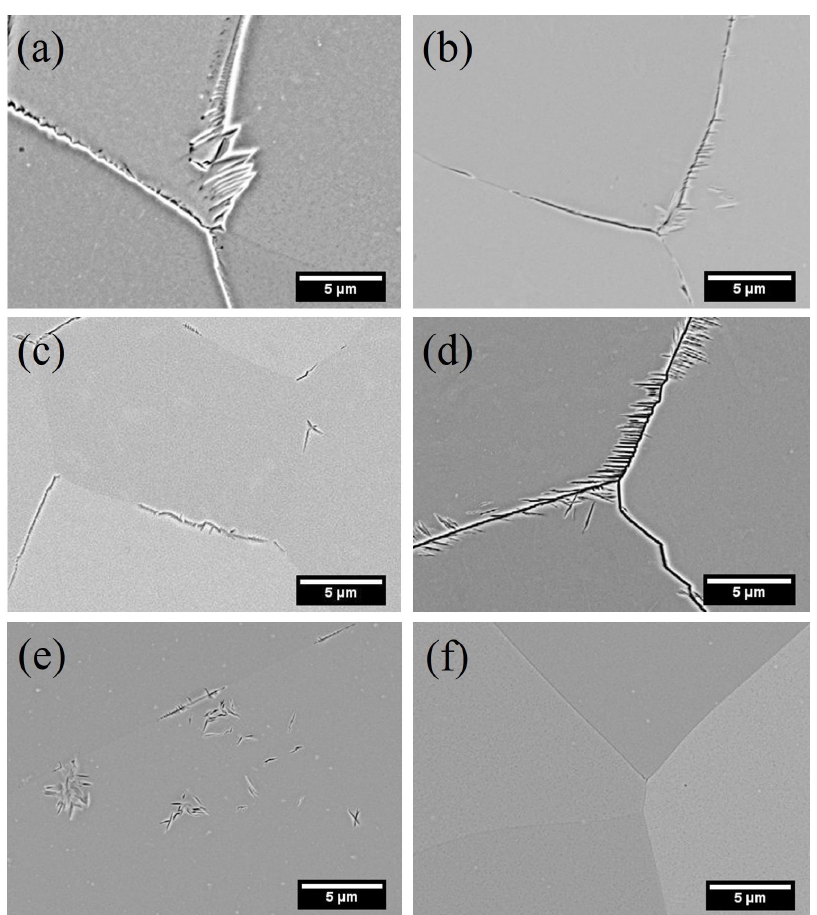
Figure 3. Microstructures of Ti-30Nb-3Fe alloy treated for 15 minutes at (a) 569 ºC, (b) 572 ºC, (c) 577 ºC, (d) 580 ºC, (e) 585 ºC, and (f) 593 ºC with subsequent water quenching. The α phase precipitation can be seen from (a) to (e) while (f) shows no α phase precipitation. SEM micrographs recorded in backscattered electron imaging